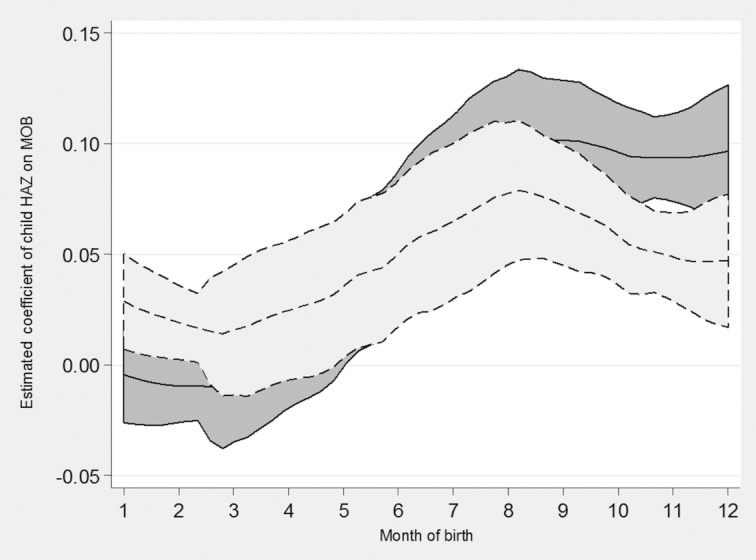
Estimated coefficients of child HAZ on MOB across 6 DHS in Bangladesh. Lines are local polynomial smoothing regressions of degree zero with 95% CIs and an Epanechnikov kernel. Solid line is estimates before the linear correction for misreported MOB. Dotted line is after the linear correction for misreported MOB. DHS, Demographic and Health Surveys; HAZ, height-for-age z-score; MOB, month of birth.